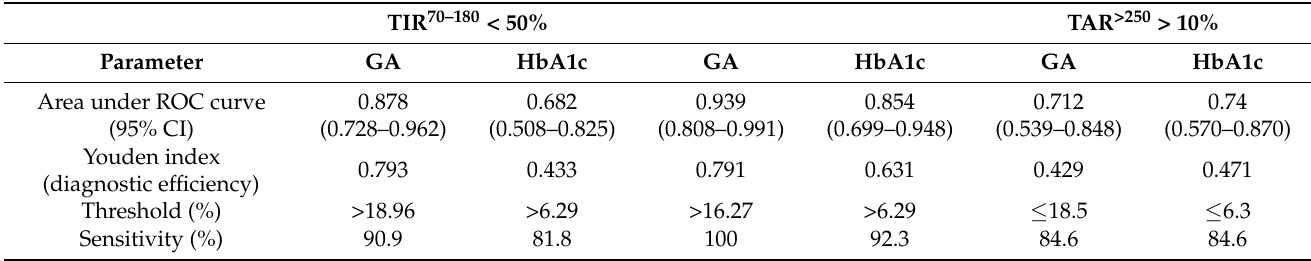
Table 2. Thresholds for GA and HbA1c in detecting a 7-day CGM-derived TIR 70–180 , TAR >250 , or TBR <70 in <50%, >10% and >1% of